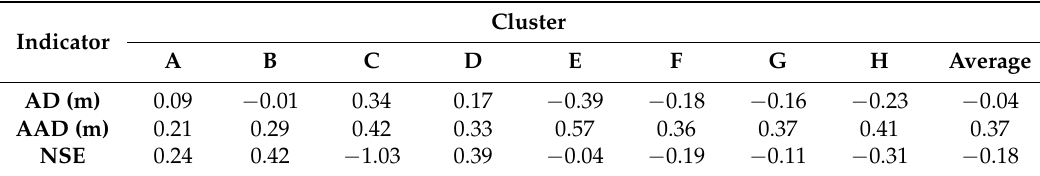
Table 1. Performance indicators for the best 2D calibration